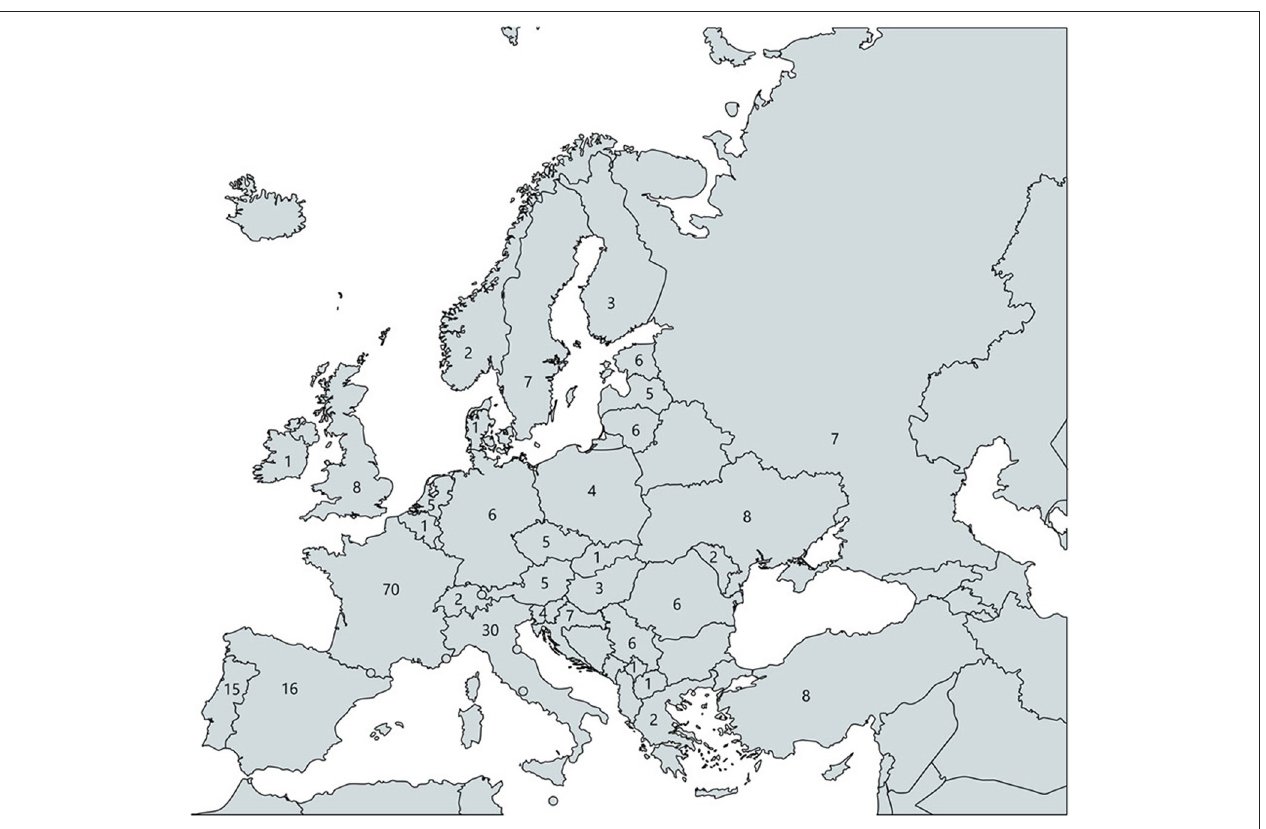
FIGURE 1 | Participants per country of current employment (created with mapchart).